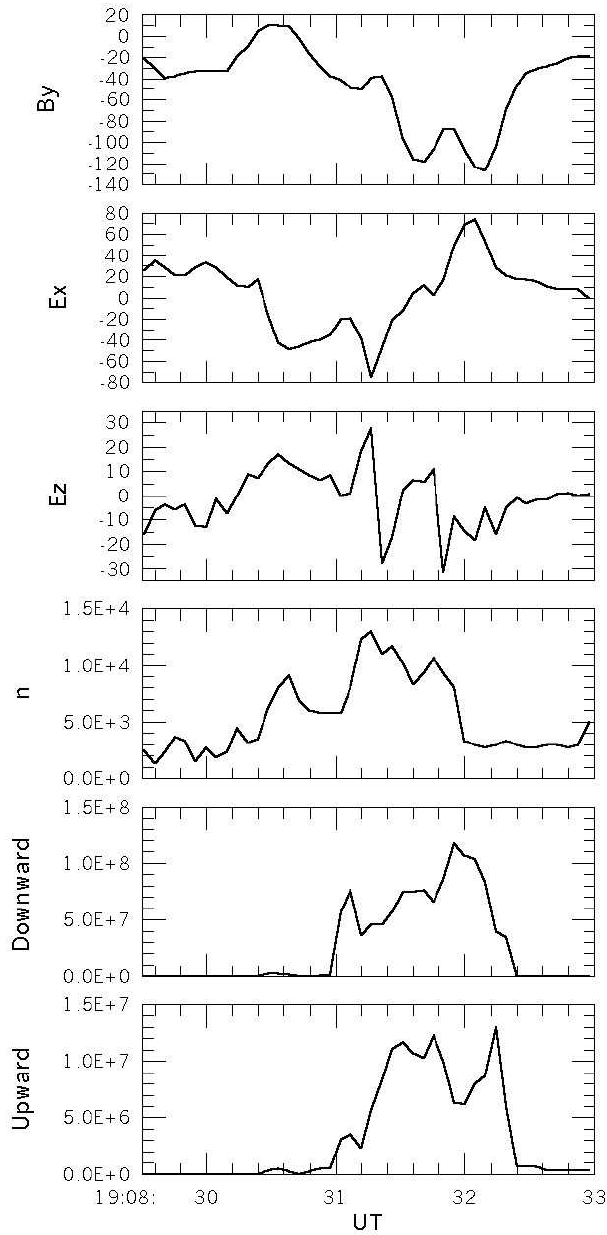
Fig. 1. An example of auroral electromagnetic perturbation ob- served by the Intercosmos-Bulgaria-1300 satellite. From top to bot- tom: transverse magnetic field B y and electric field E y perturba- tions, parallel electric field E z , number density n , and downward and upward fluxes of electrons with the energy